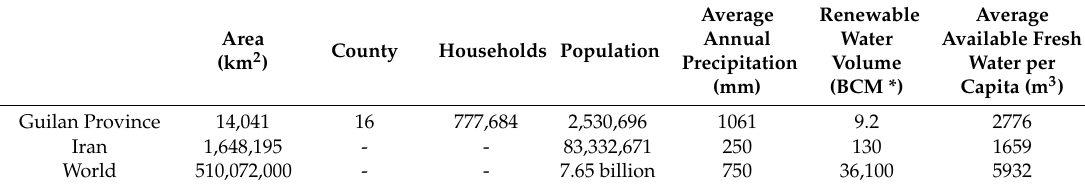
Table 1. Status of the province’s water and population resources.